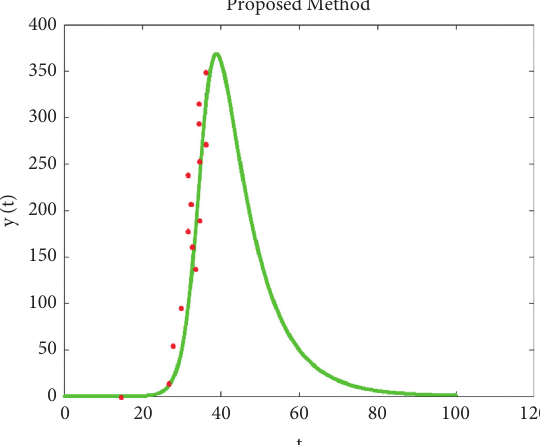
Figure 19: Comparison of simulated result with real